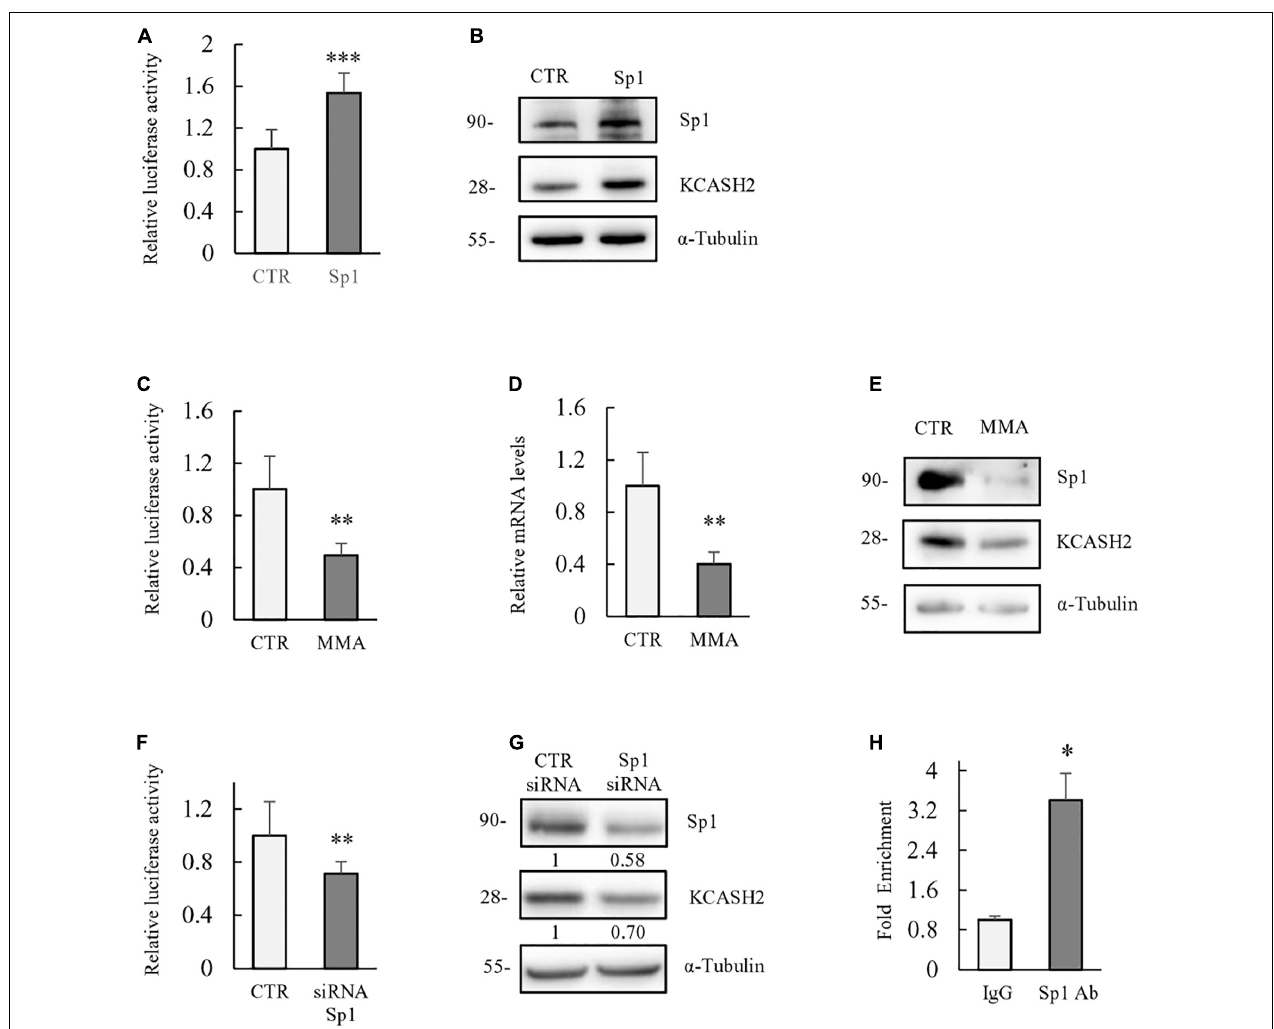
FIGURE 2 | Basal transcriptional activity of human KCASH2 promoter is driven by Sp1. (A,B) Sp1 ectopic expression increases KCASH2 promoter activity and KCASH2 protein levels. (A) HEK293T were co-transfected with the KCASH2 promoter luciferase reporter, together with control (CTR) vector or Sp1 expressing plasmid. Luciferase activity was normalized to the control. ∗∗∗ p < 0.001. (B) HEK293T were transfected with empty vector or Sp1 expressing vector; 24 h later, cells were lysed and analyzed by Western blot, using Sp1 and KCASH2 antibodies. Tubulin was used as loading control. (C–G) Inhibition of Sp1 leads to a decrease in KCASH2 reporter activity, KCASH2 mRNA, and protein levels. (C) HEK293T cells were co-transfected with KCASH2-Luc reporter and treated with MMA (200 nM) for 24 h. Luciferase activity was normalized to mock treated cells (CTR). ∗∗ p < 0.01. (D,E) HEK293T cells were cultured with MMA (200 nM) for 48 h. Then, cells were lysed and KCASH2 mRNA (D) and protein levels (E) were evaluated by RT-qPCR and Western Blot, respectively. KCASH2 mRNA levels were normalized to GAPDH, TBP, ß2M, and represented as fold-induction of the CTR. ∗∗ p < 0.01. Western Blot was performed as above. Transfection efficiency in luciferase experiments was normalized by co-transfection of a pRL–TK–Renilla reporter. All experiments represented are the mean of three independent experiments ± standard deviation (SD). (F) Relative luciferase activity was measured in HEK293T cells transfected with scrambled siRNA (siCTR) or with Sp1 siRNA followed by KCASH2-Luc reporter and pRL–TK Renilla. Luciferase activity was normalized to the control. ∗∗ p < 0.01. (G) HEK293T were transfected with siCTR or with Sp1 siRNA, 24 h later, cells were lysed and analyzed by Western Blot, using Sp1 and KCASH2 antibodies. Tubulin was used as loading control. Band intensities were analyzed using image J software and numbers below the boxes represent the relative quantification of protein levels. (H) Sp1 binds in vivo to the KCASH2 promoter sequence. Cross-linked chromatin was extracted from HEK293T cells and immunoprecipitated with a relevant control IgG or specific anti-Sp1